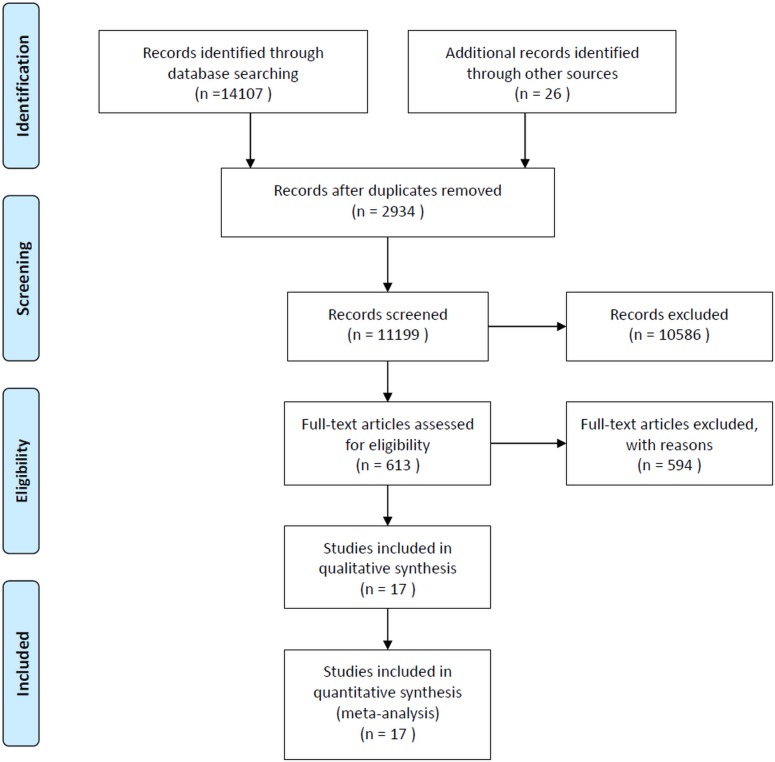
PRISMA flow diagram.